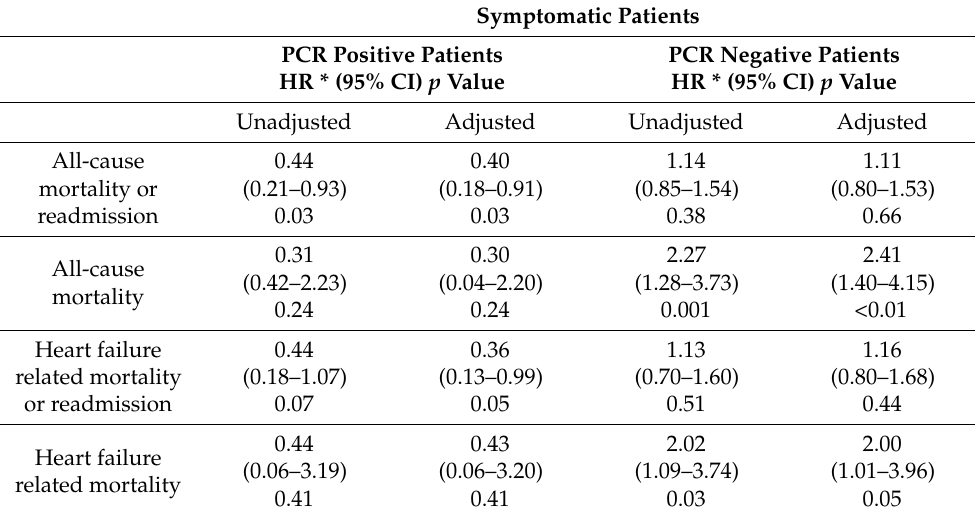
Table 3. Association of viral testing status with 90 day clinical outcomes expressed as hazard ratios in symptomatic patients as compared to patients without flu-like